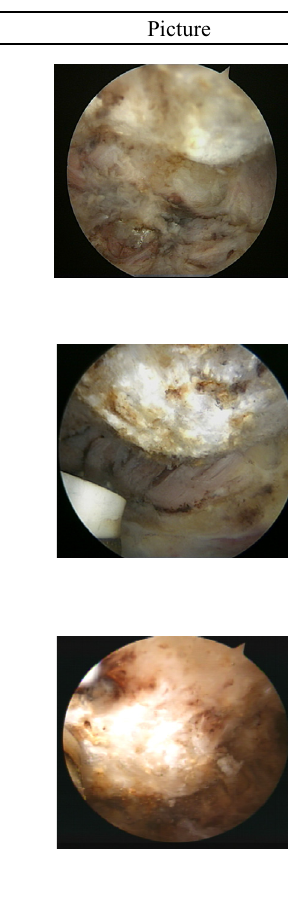
Table 1. Describes the arthroscopic morphological classification of the acromion spur with the arthroscopic picture for each